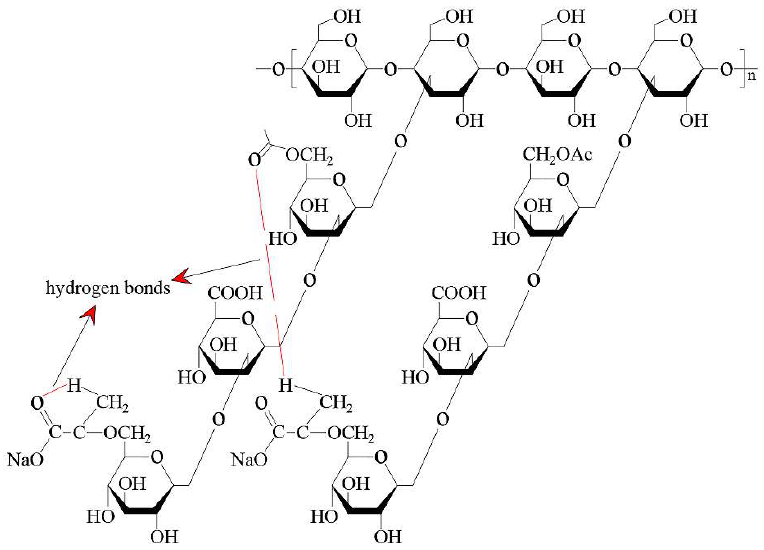
Figure 7. Structure of xanthan gum (XG) molecular chain